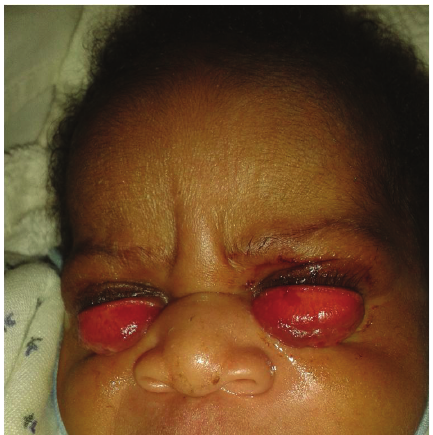
Figure 2: Significant reduction in chemosis on day 2.